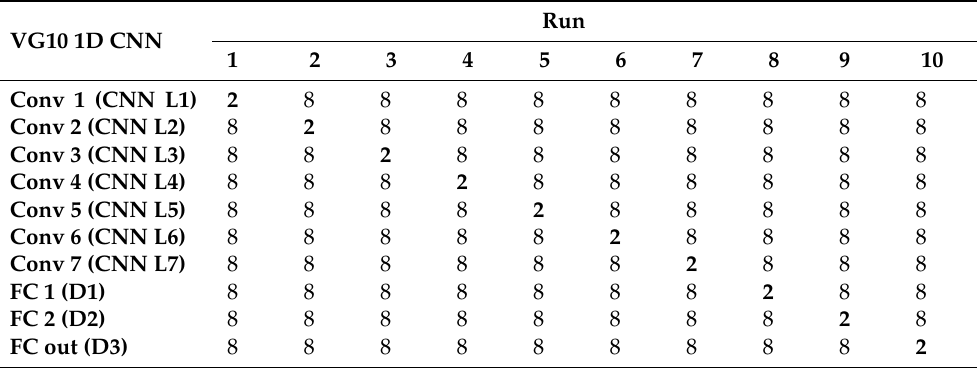
Table 3. Example of quantization in each layer independently; in this case, the inputs and activations were statically set to a given value (e.g., 8 bits) while the quantization values of the weights were varied in each run at a given layer (e.g., 2